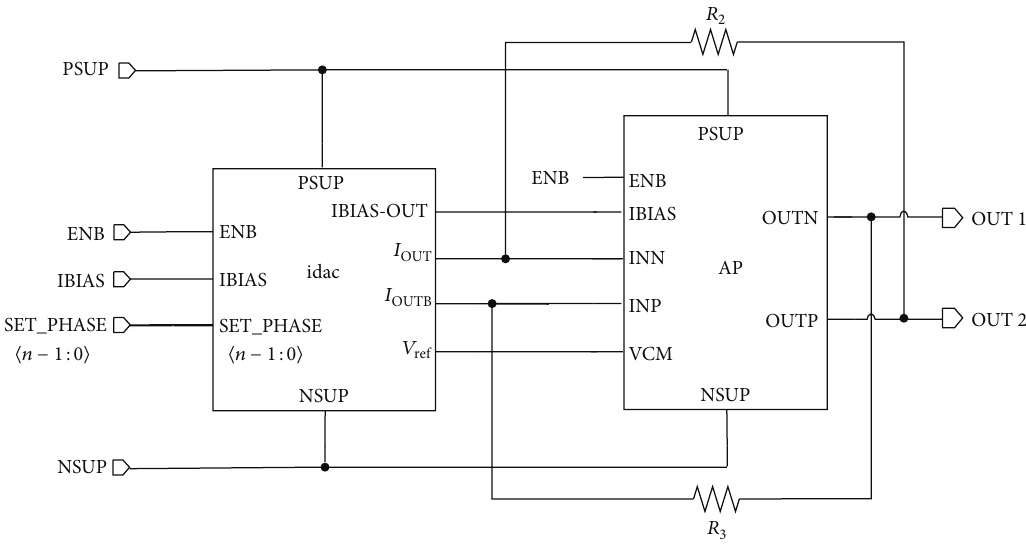
Figure 3: Circuit structure of the phase precision regulator unit.